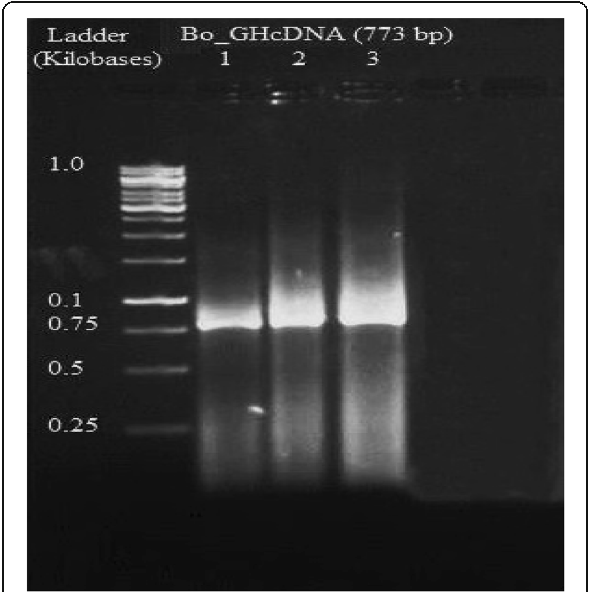
Fig. 2 Gel electrophoresis bands of Bo_GH